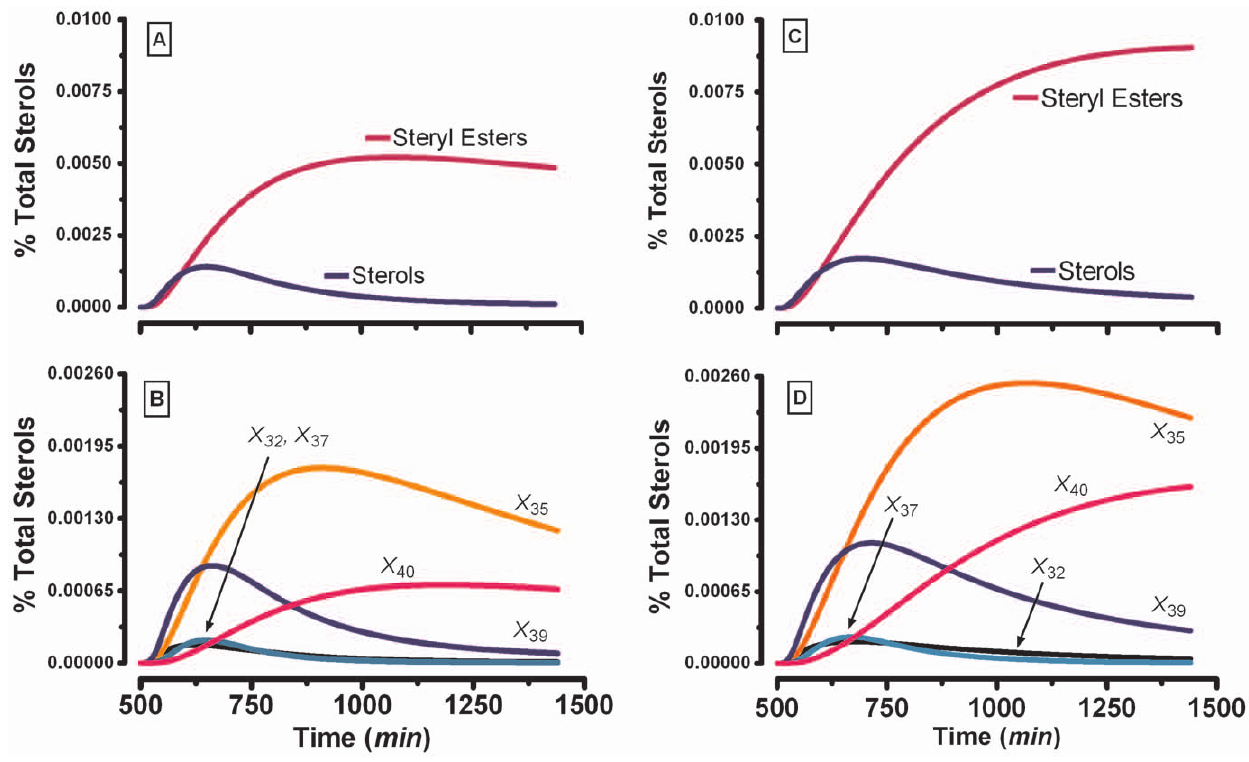
Figure 5. SL-E model results for an external pulse-chase bolus similar to the one in Fig. 3F. Pools : Steryl-esters ( X 33 + X 34 + X 35 + X 40 ), Sterol ( X 30 + X 31 + X 32 + X 36 + X 37 + X 39 ). Ergosterol sub-populations : ergosterol in endoplasmic reticulum ( X 32 ), ergosterol steryl-ester 1 ( X 35 ), ergosterol associated with the complex sphingolipids ( X 37 ), plasma membrane ergosterol in inner leaflet ( X 39 ), ergosterol steryl-ester 2 ( X 40 ). ( A ) Decrease to 1% in IPC synthase activity ( X 133 ). Dynamic simulation for the steryl-esters pool and total sterols after pulse-chase bolus with labeled acetate. ( B ) Decrease to 1% in IPC synthase activity ( X 133 ). ( C ) Decrease to a 1% in serine palmitoyl transferase activity ( X 157 ). Dynamics simulation for the steryl- esters pool and total sterols after pulse-chase bolus with labeled acetate. ( D ) Decrease to a 1% in serine palmitoyl transferase activity ( X 157 ).